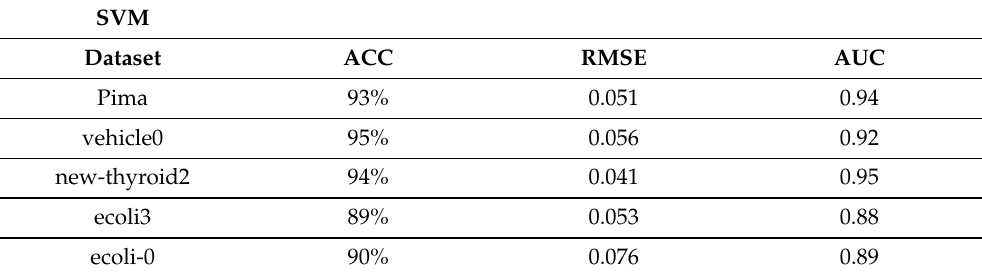
Evaluation Results for the proposed algorithm to handle the imbalanced class problem—SVM.